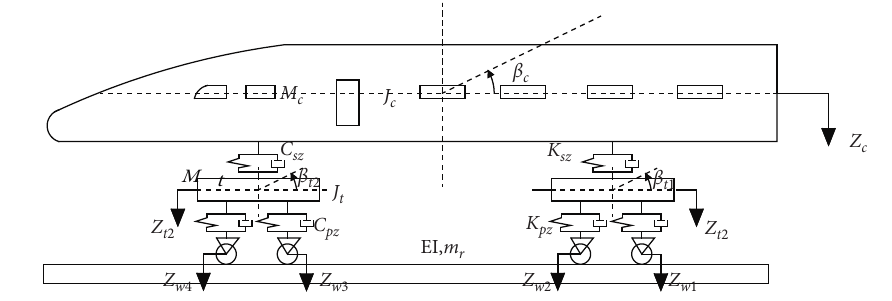
Figure 1: Train calculation Table 1: Calculation parameters of train model.